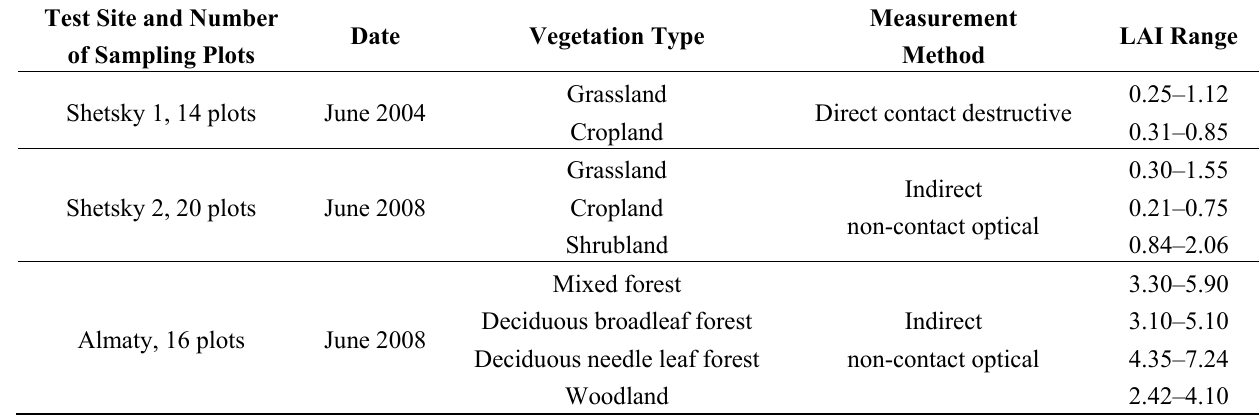
Table 2. In situ measurements of Leaf Area Index (LAI) in Kazakhstan used in this study. For the location of the test sites, see Figure